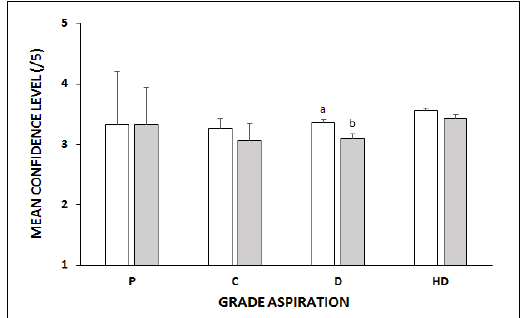
Figure 2: Mean student confidence levels based on grade aspiration, and grouped according to prior biology study (white columns) and no prior biology study (light grey columns). Error bars denote SEMs; non-shared alphabet letters denote a significant difference between mean scores for the aspired grade. See Table 1 for n values for each cohort/grade aspiration